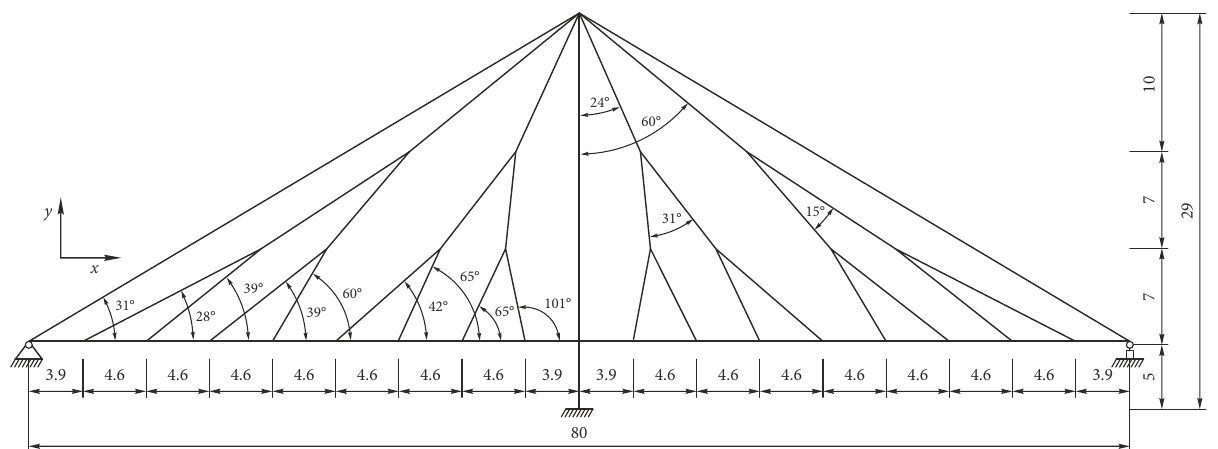
Figure 1. The scheme of the branched cable-stayed